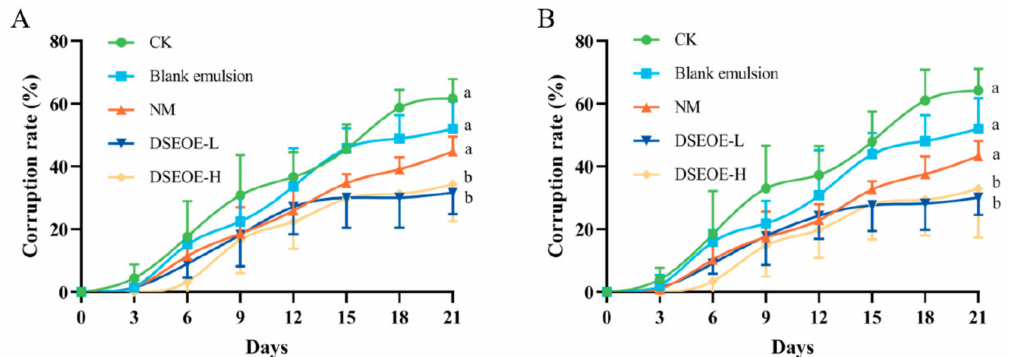
Figure 10. The effect of DSEO emulsion on the storage period of chestnut. ( A ) The number of spoiled chestnuts calculates the spoilage rate of chestnuts; ( B ) The weight of spoiled chestnuts calculates the spoilage rate of chestnuts. NME, 200 µ g/mL NM emulsion; DSEOE-L, 1.5 µ L/mL DSEO emulsion; DSEOE-H, 7.5 µ L/mL DSEO emulsion. Different letters (a and b) indicate a significant difference ( p < 0.05). “CK” represents